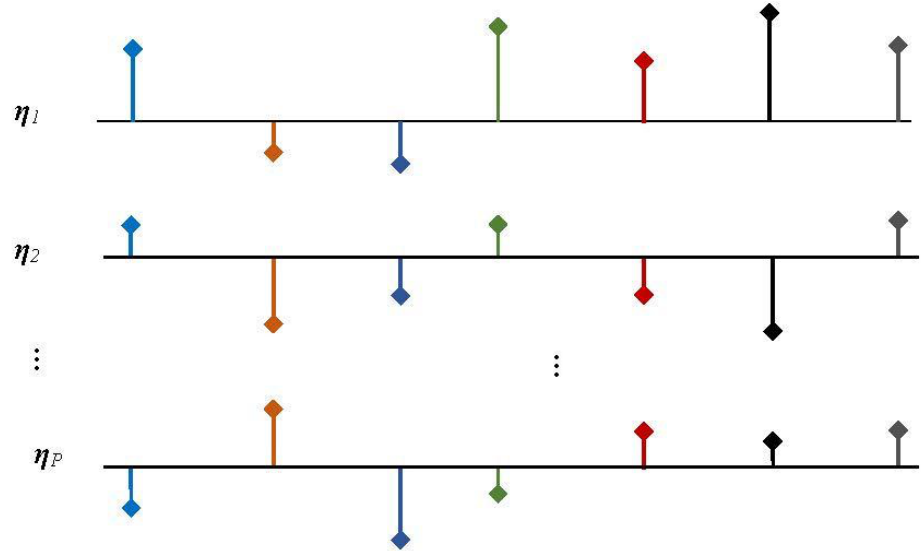
Figure 4. JSM-2 in distributed compressive